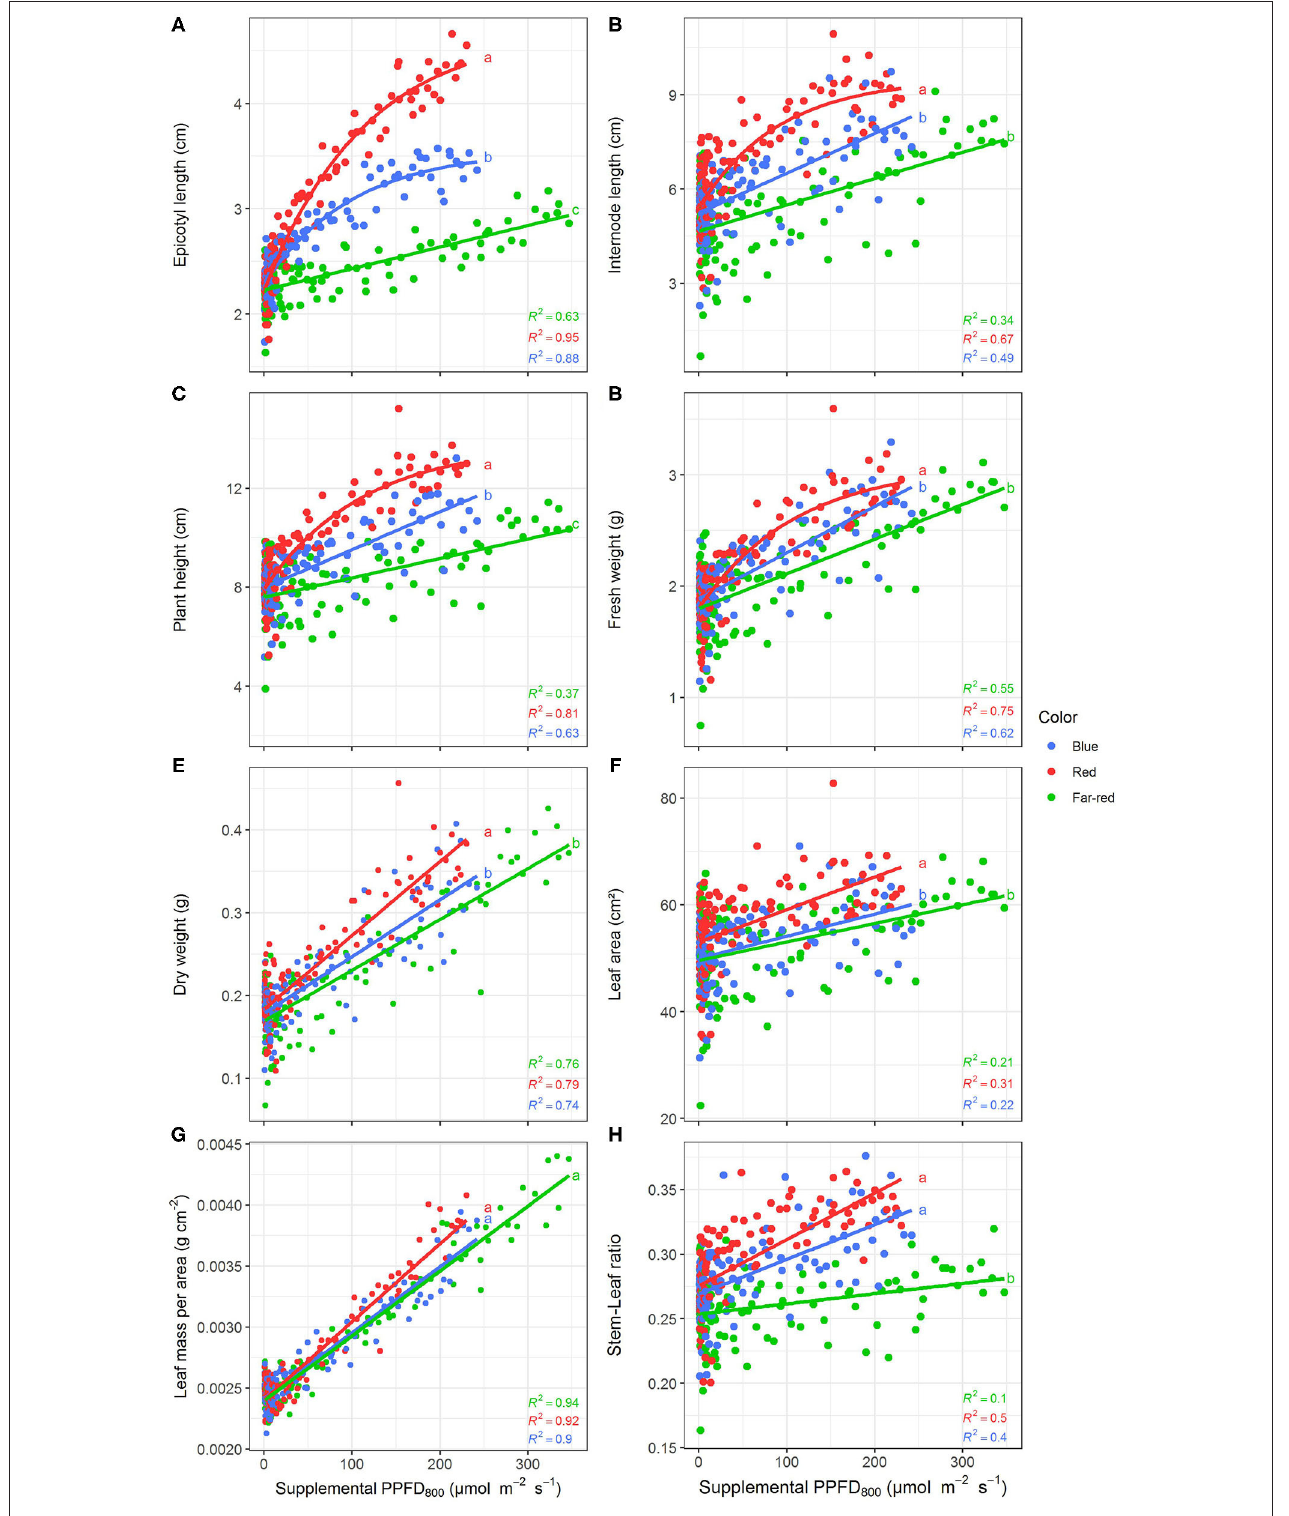
FIGURE 7 | Effect of supplemental PPFD 800 (400–800nm) with different spectra on epicotyl length (A) , total internode length (B) , height (C) , fresh weight (D) , dry weight (E) , leaf area (F) , leaf mass per area (G) , and stem-leaf ratio (H) of Ocimum basilicum L. cv. “Edwina” cultivated under greenhouse conditions.